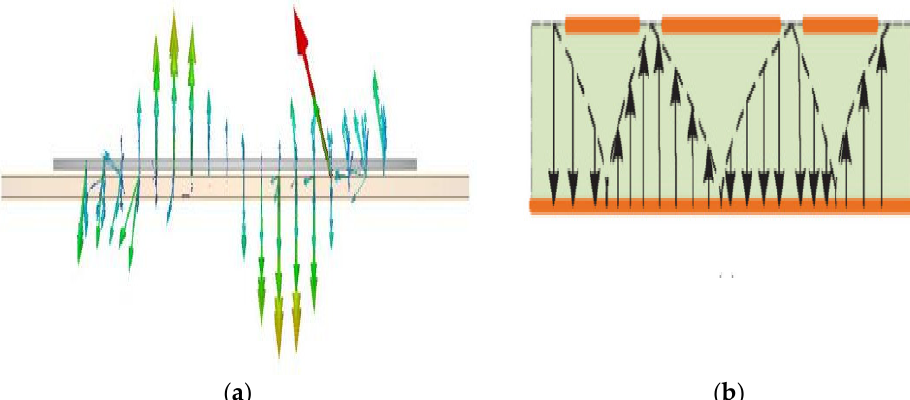
Figure 7. ( a ) E-field distribution of the Ant. 3 at 5.38 GHz. ( b ) Sketch of the operation mechanism at TM 03 mode.